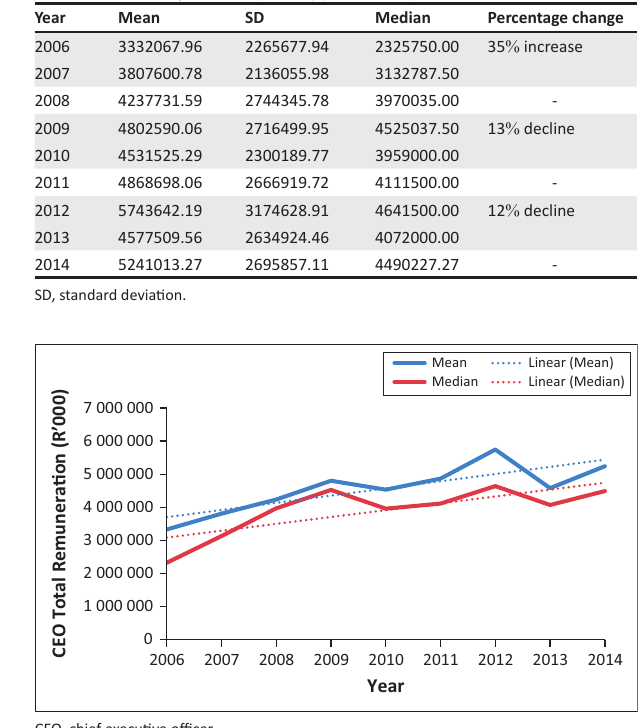
TABLE 4: Total compensation (R‘ 000) (2006–2014).